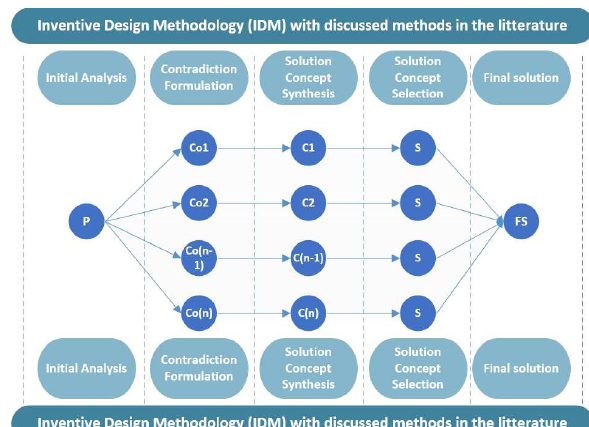
Figure 5. LA-IDM with Inverse Problem Graph